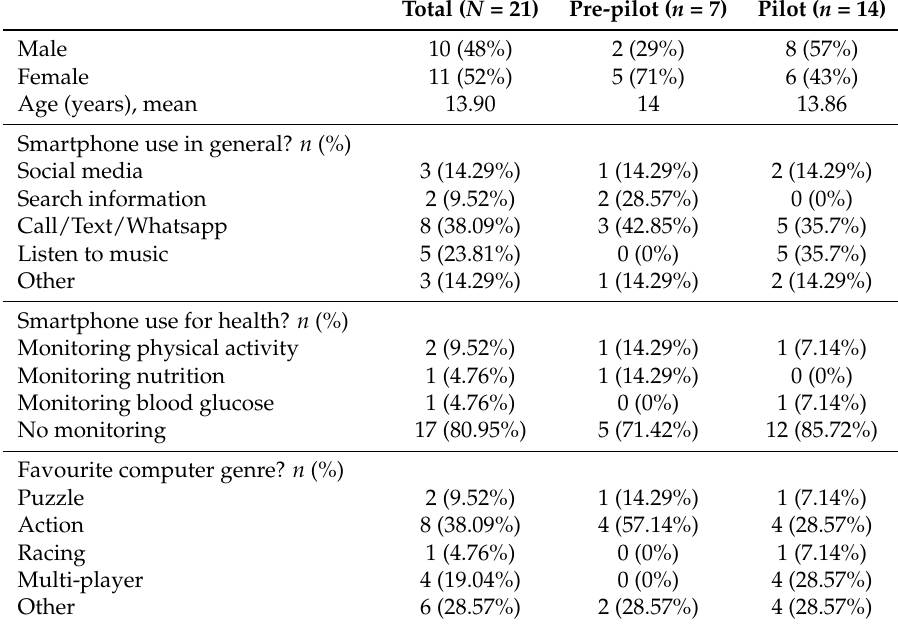
Table 3. Socio-demographic characteristics and smartphone use in both study groups ( N =